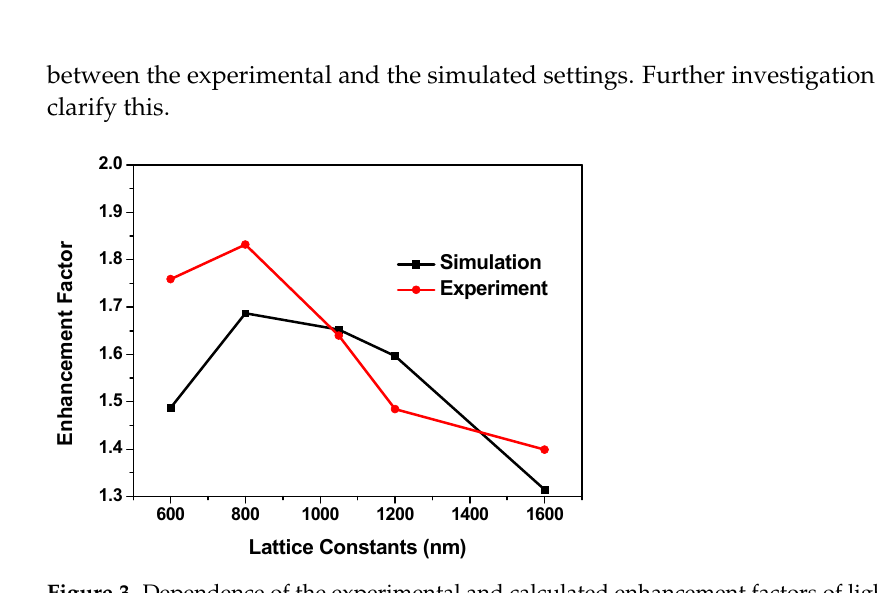
results was consistent with the experimental ones. The experimental and calculated re-